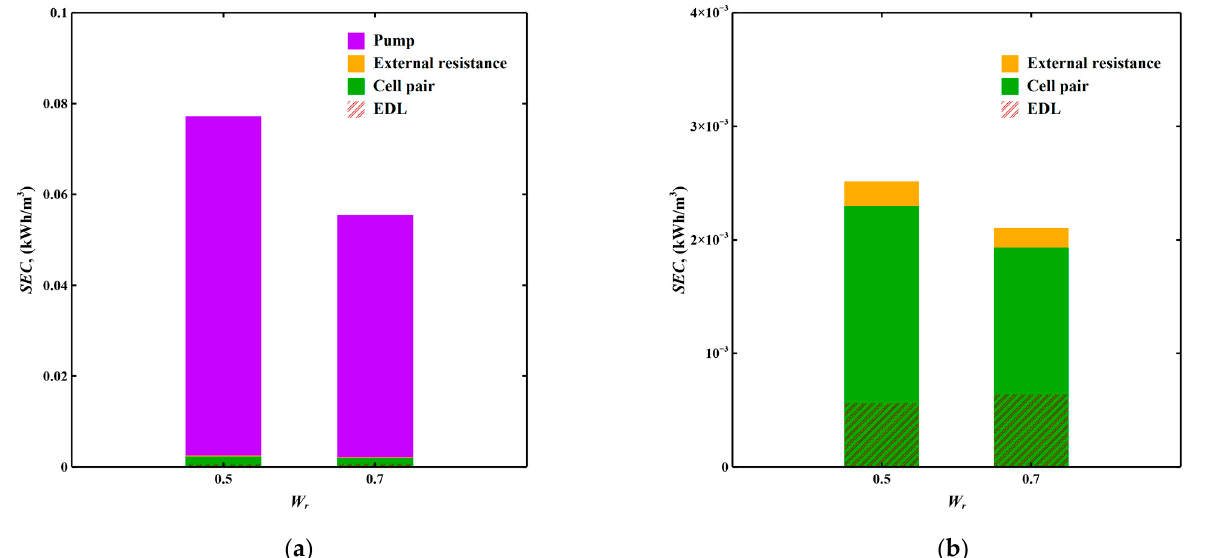
Figure 5. ( a ) SEC with the contribution of each component including pump, external resistance and cell pair and the energy stored in EDL with varying water recovery under quasi-steady state in cut-off CV mode MCDI for slightly softening domestic tap water; ( b ) SEC without pump losses. Applied voltage is 0.08 V.